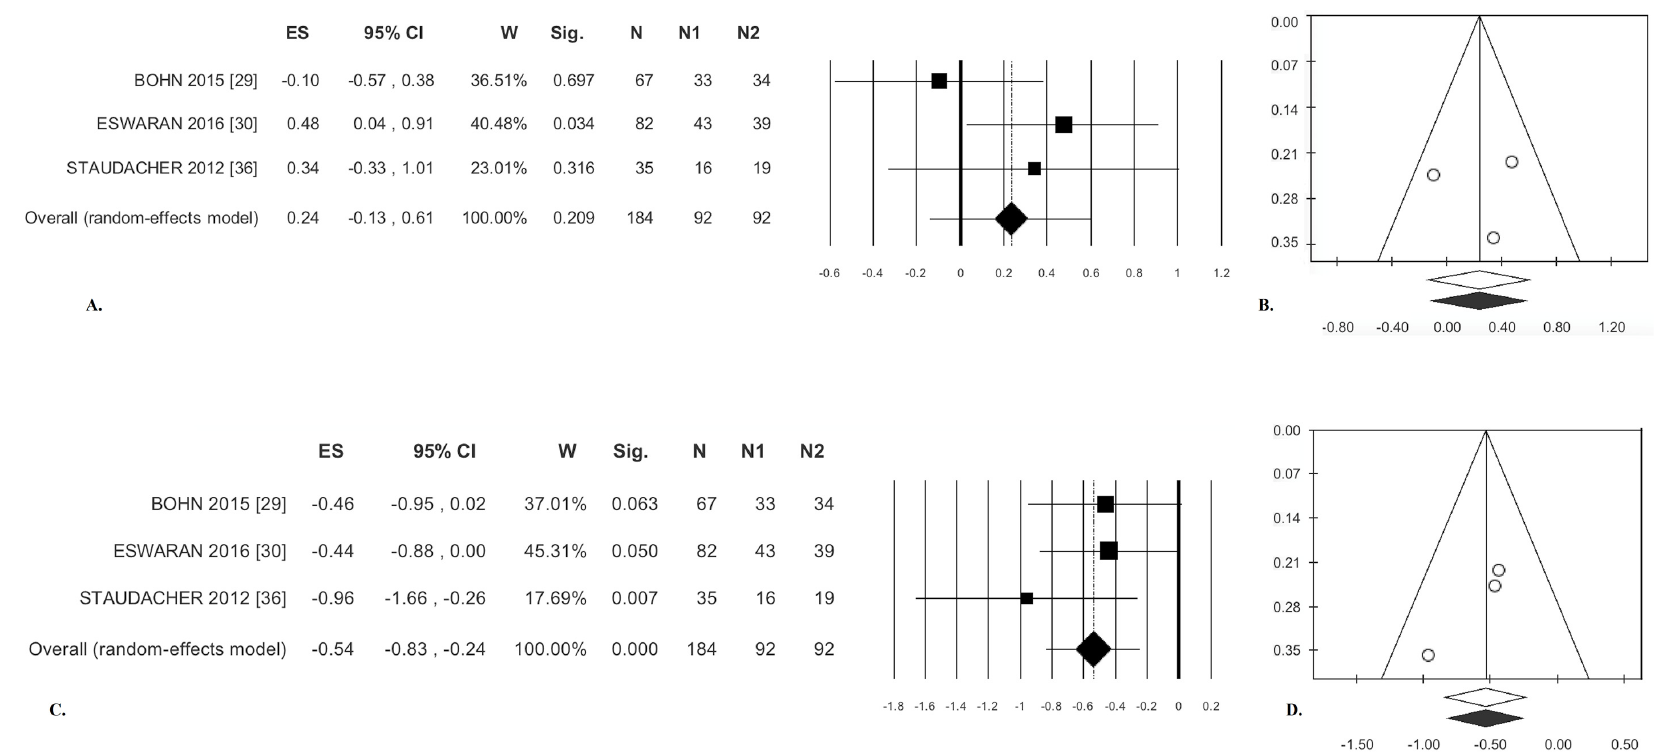
Figure 3. Low ‐ FODMAP diet versus traditional IBS diet. Stool consistency: ( A ) forest plot and ( B ) funnel plot. Stool frequency: ( C ) forest plot and ( D ) funnel plot.